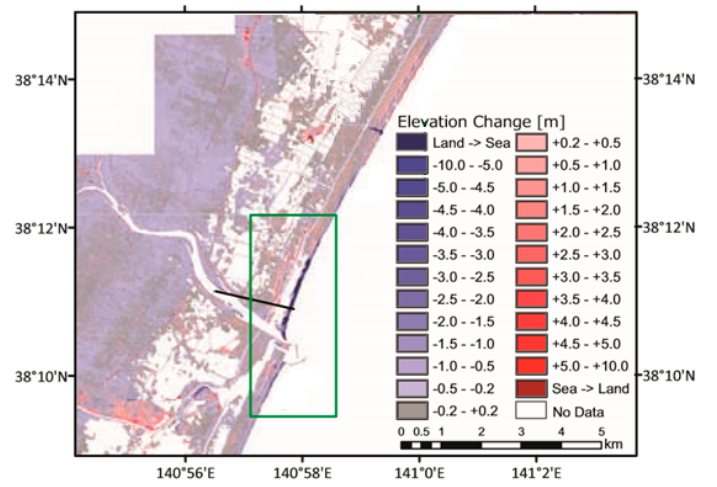
Figure 8. Topography change results from the measured data after the 2011 Tohoku tsunami, adapted from (Udo et al., 2012) [22] with permission from publisher, TAYLOR & FRANCIS, (2020).